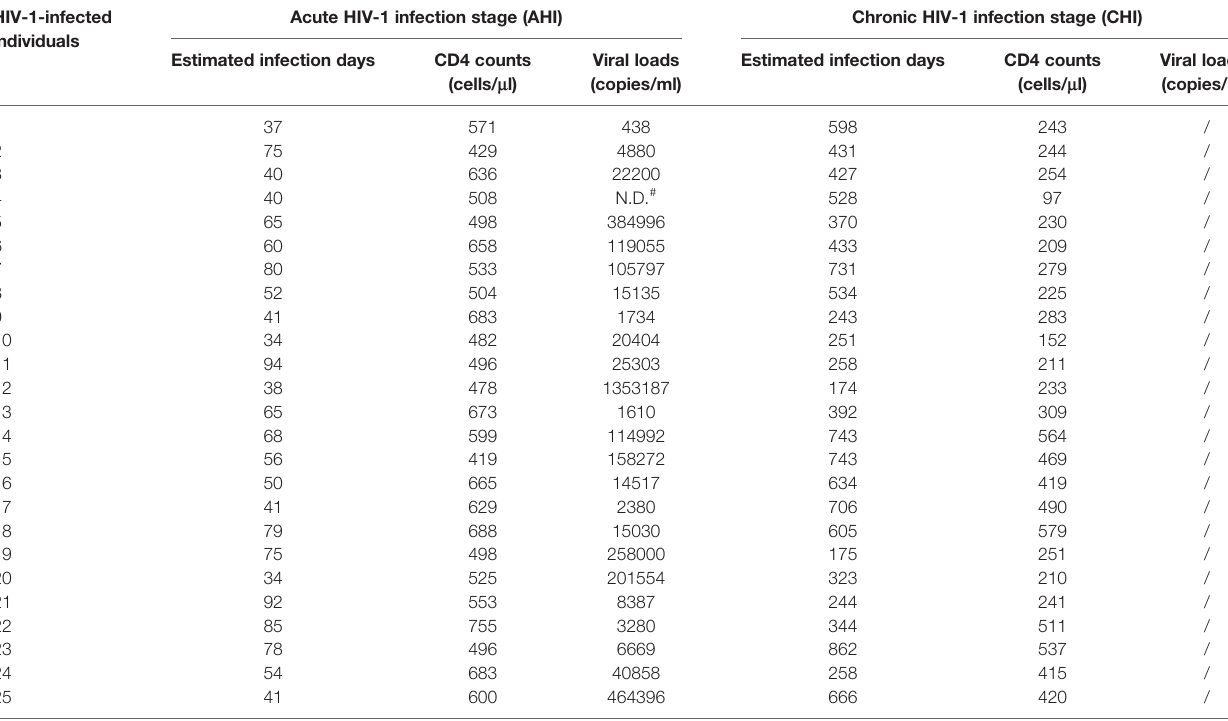
TABLE 1 | Characteristics of HIV-1-infected individuals. HIV-1-infected